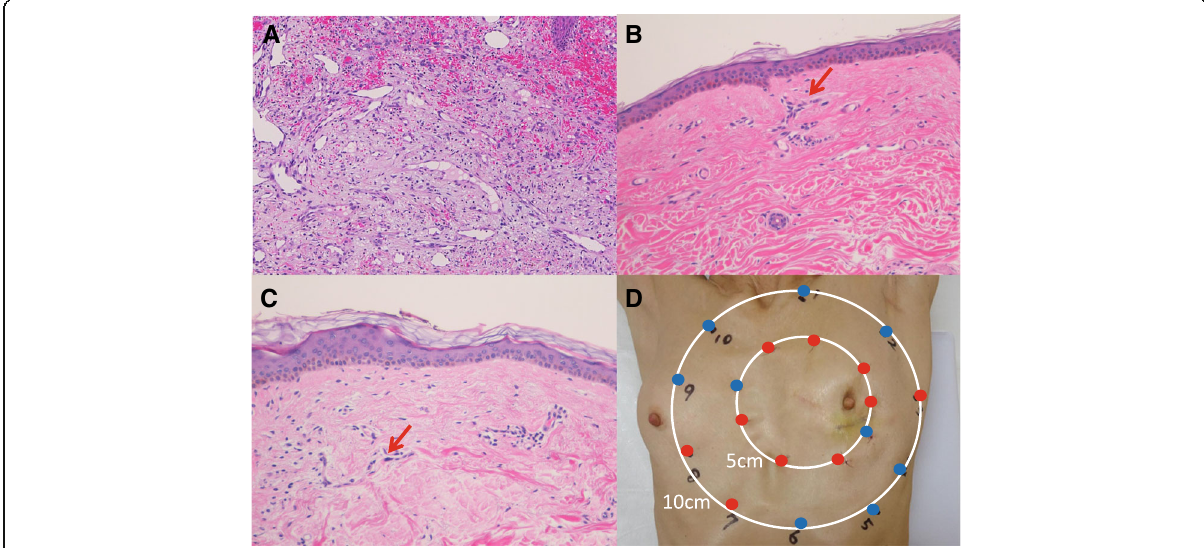
Fig. 3 Macroscopic and microscopic pathological findings (case 2). a The nodule was diagnosed as angiosarcoma by open biopsy (H.E. staining: × 20). b Mapping biopsy 5 cm from the surgical trace (H.E. staining: × 20). Arrow: atypical endothelial cells. c Mapping biopsy 10 cm from the surgical trace (H.E. staining: × 20). Arrow: atypical endothelial cells. d Mapping biopsy was performed 5 cm and 10 cm away from the surgical trace. The red dots indicate areas where atypical endothelial cells were observed, and blue dots indicate areas where no atypical endothelial cells were